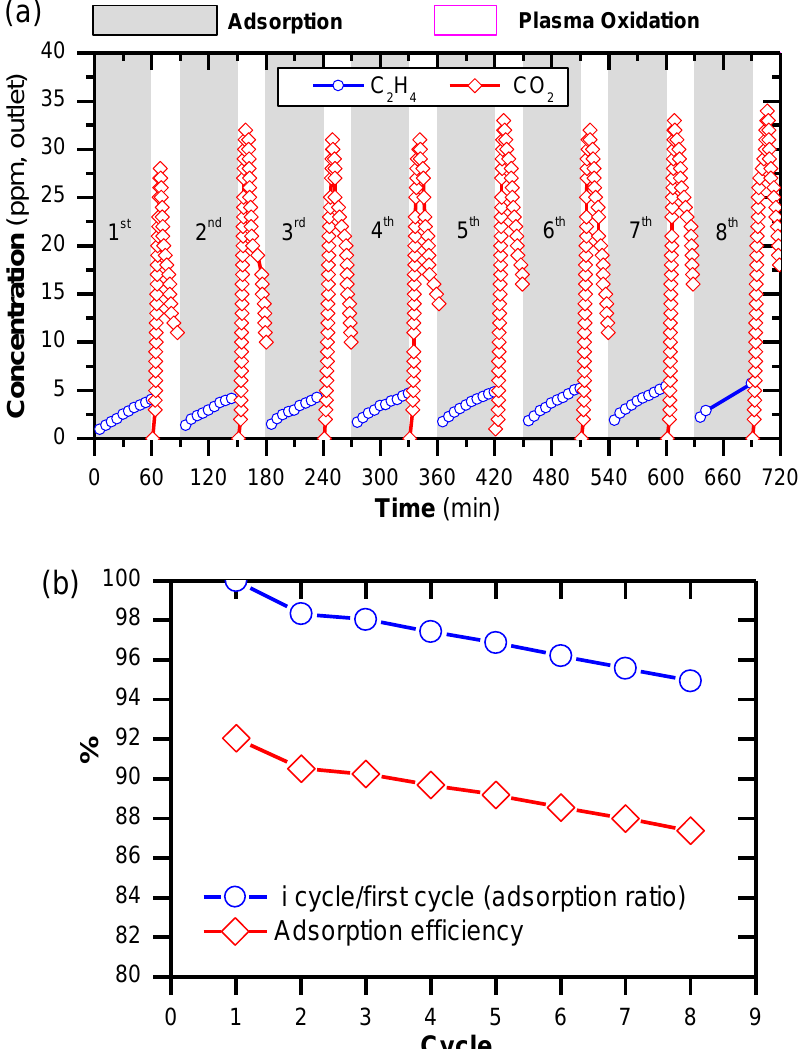
Figure 5. ( a ) Concentration of C 2 H 4 and CO 2 in the gas outlet with adsorption and plasma-catalytic oxidation performed within 8 cycles, and ( b ) adsorption ratio between i cycle and first cycle, and adsorption efficiency as a function of a cycle number (in one cycle: adsorption time = 60 min and oxidation time = 30 min; total flow rate: 2 L/min: 30 ppm C 2 H 4 in feed during adsorption steps during adsorption step, O 2 as feed gas and absence of C 2 H 4 during the oxidation step, and the consumed power of 15 W).